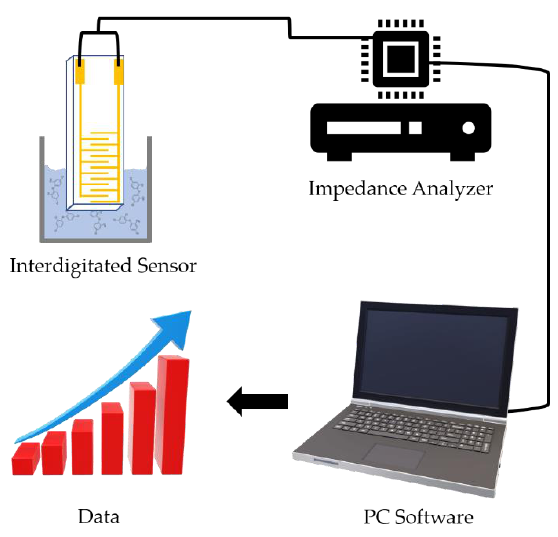
Figure 1. Schematic illustration of the experimental setup.